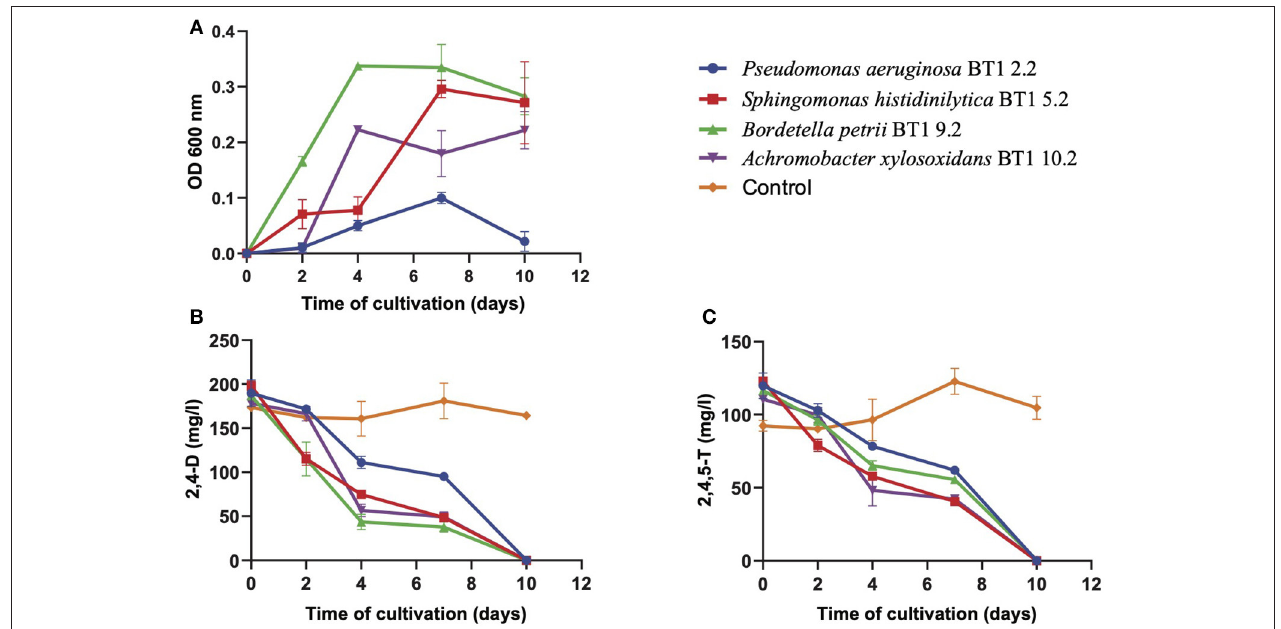
FIGURE 1 | Bacterial growth (A) , degradation of 2,4-D (B) , and degradation of 2,4,5-T (C) in mineral salt medium with a mixture of 2,4-D and 2,4,5-T inoculated with either of the four isolated species listed. The optical density (OD 600 nm) at the start of each growth curve (0.32 for P. aeruginosa BT1 2.2, 0.26 for S . histidinilytica BT1 5.2, 0.32 for B. petrii BT1 9.2, and 0.39 for A. xylosoxidans BT1 10.2) was subtracted from those further on in these curves. Symbols are the means of three replicates. Results are shown as averages of triplicate cultures, with the error bars representing standard